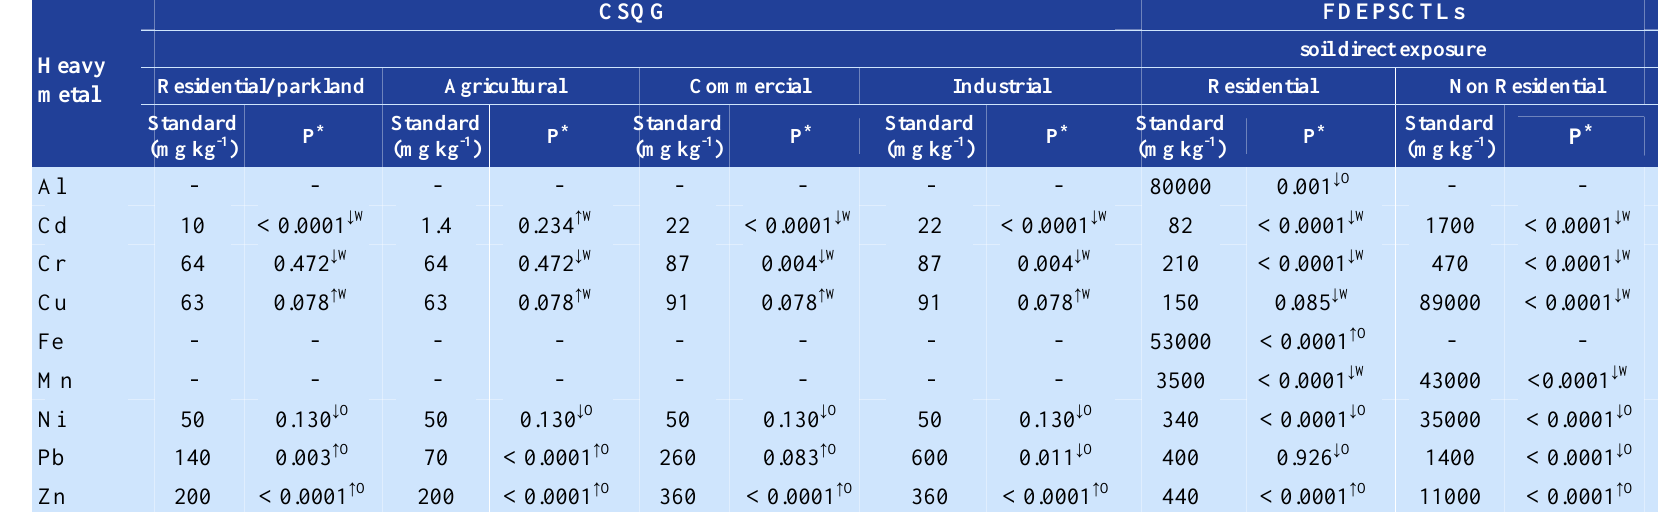
Table 3. Statistical results of comparing the investigated heavy metals with the standards determined by CSQG and FDEPSCTLs